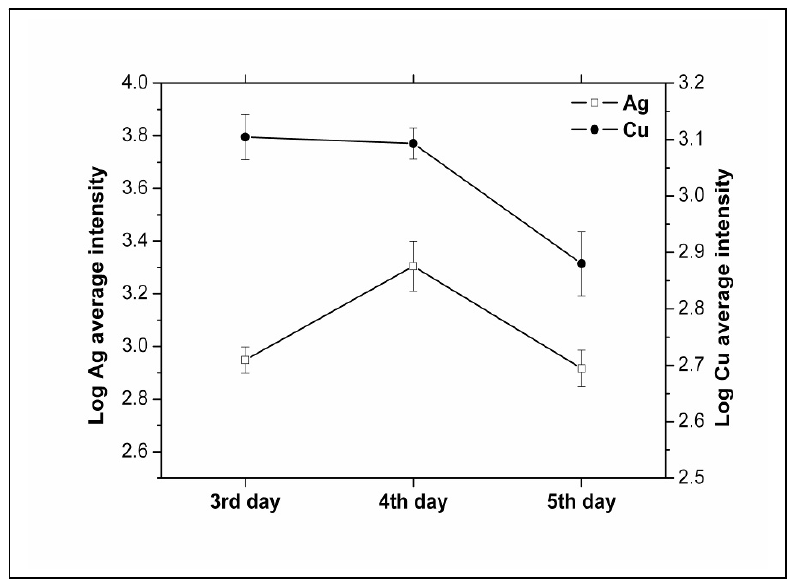
Figure 7. The average intensities calculated from logarithm of intensity data obtained from LIBS analyses.